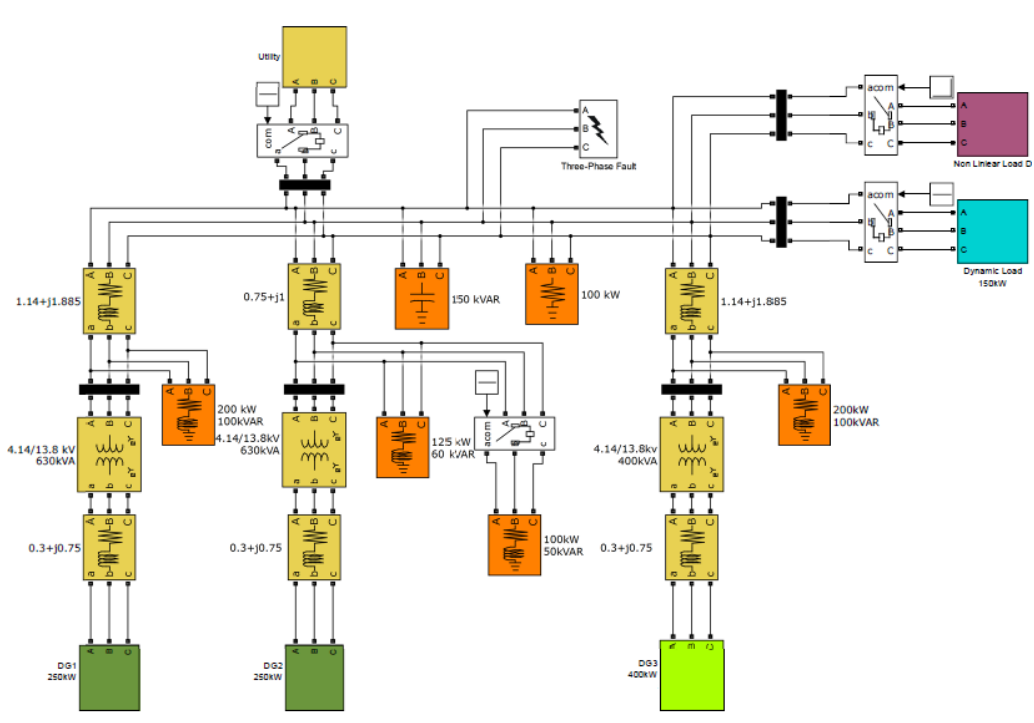
Figure 9. Simulation of micro grid by MATLAB/SIMULINK software (R2014a).